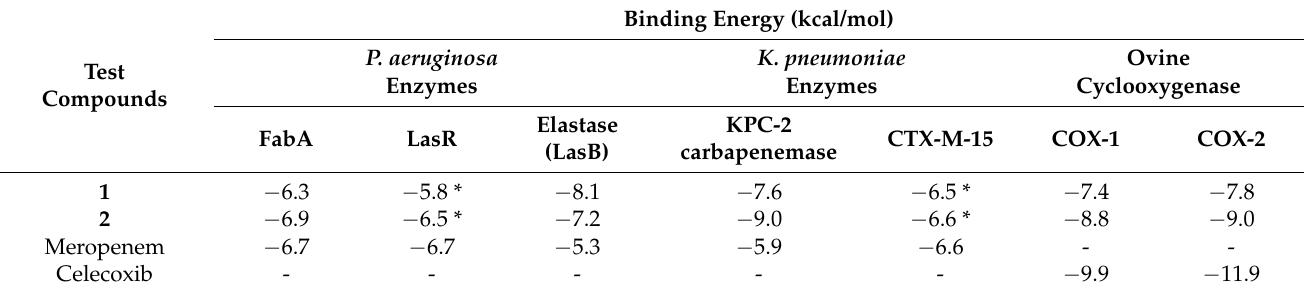
Table 2. Binding affinities of P. ophthalmicus alkaloids against target